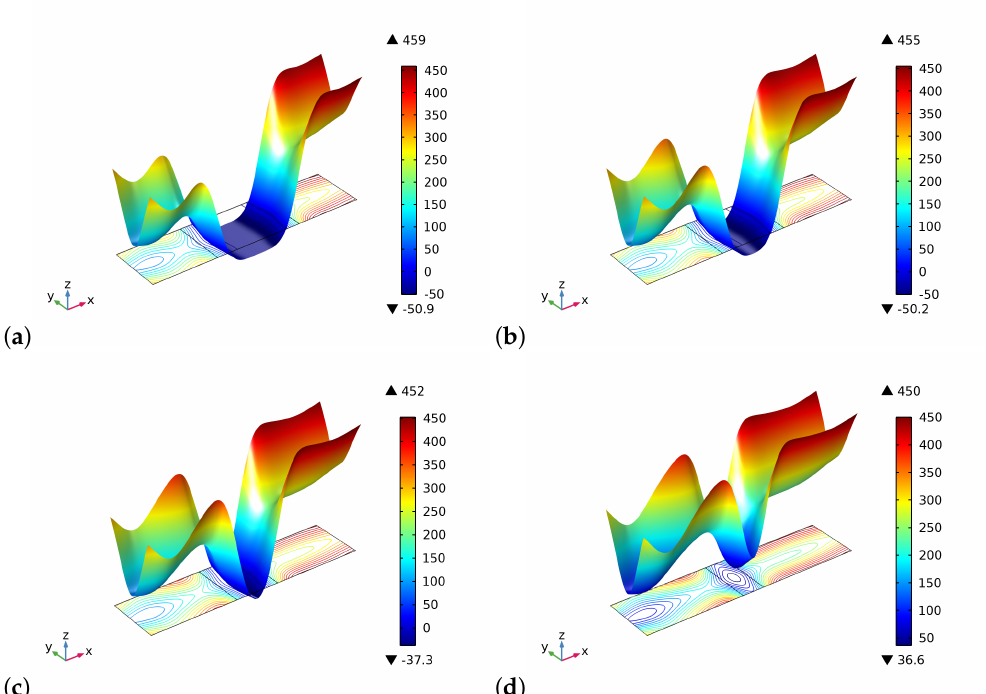
Figure 4. The initial distribution of the stimulus S as determined by the external actions for different substitute lengths of the graft: ( a ) 0.8 cm. ( b ) 0.6 cm. ( c ) 0.4 cm. ( d ) 0.2